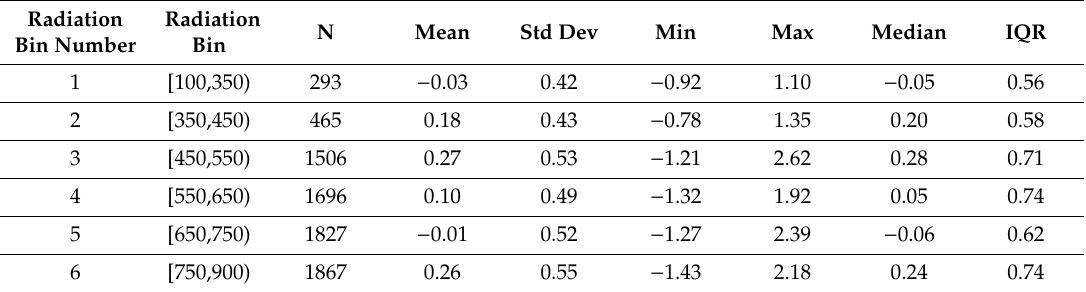
Table A4. Statistics of the Temperature Di ff erences between each of the iMET-XQs and the 1.5 m tower sensor ( ◦ C) in five solar radiation bins used to assess the accuracy of the iMET-XQ sensors as a function of solar radiation. IQR stands for Inter-Quartile